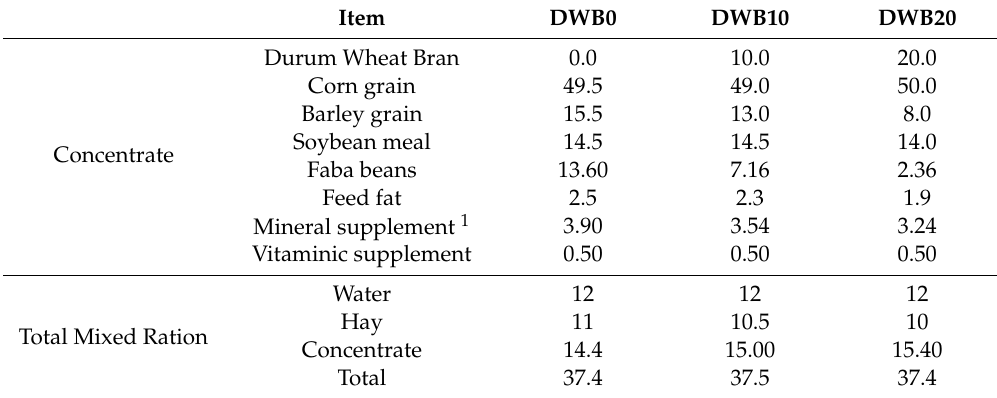
Table 1. Composition of concentrates (%) and total mixed rations (kg / day per head, TMR) o ff ered to the experimental